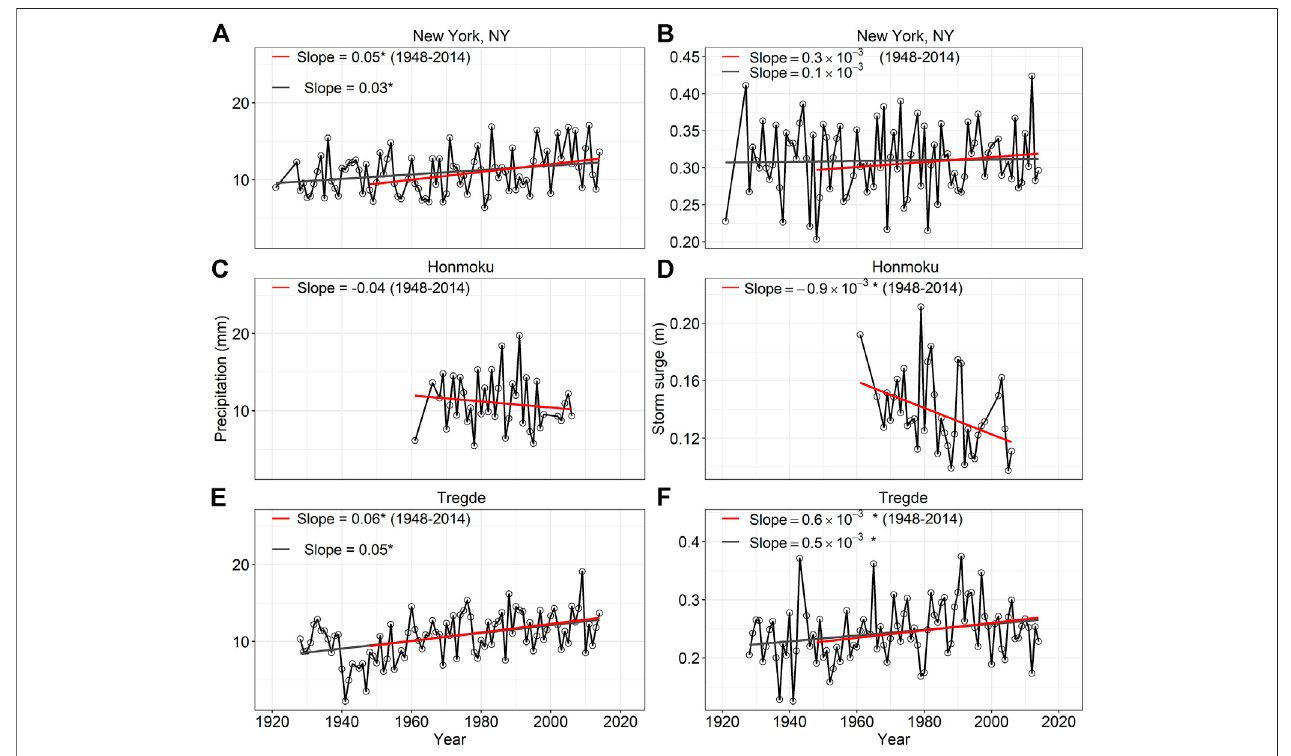
FIGURE8| Temporalevolutionof (A,C,E) precipitationunderextremestormsurge,and (B,D,F) stormsurgeunderextremeprecipitationintidegauge (A,B) New York,NY (C,D) Honmoku,and (E,F) Tregde.Theblackstraightlinein (A) and (C) indicatesthetrendofthecompletetimeseries.Theredstraightlineindicatesthetrend of the time series during 1948 – 2014. The Sen ’ s slopes were estimated. Signi fi cant trends were identi fi ed by an asterisk ( α (cid:1) 0.1).